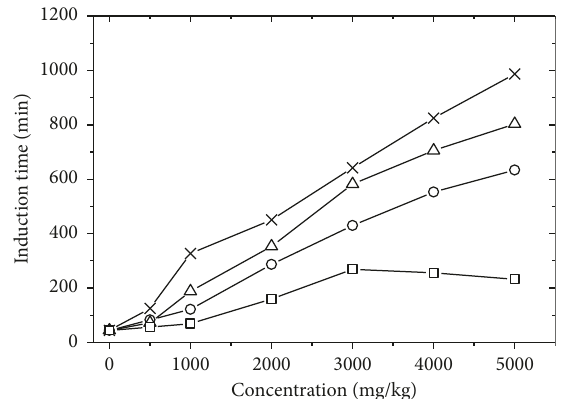
Figure 9: Experimental induction times of BL4 as a function of antioxidants concentrations. □ , U-CDN; △ , S-CDN; ◯ , DBPC; × ,